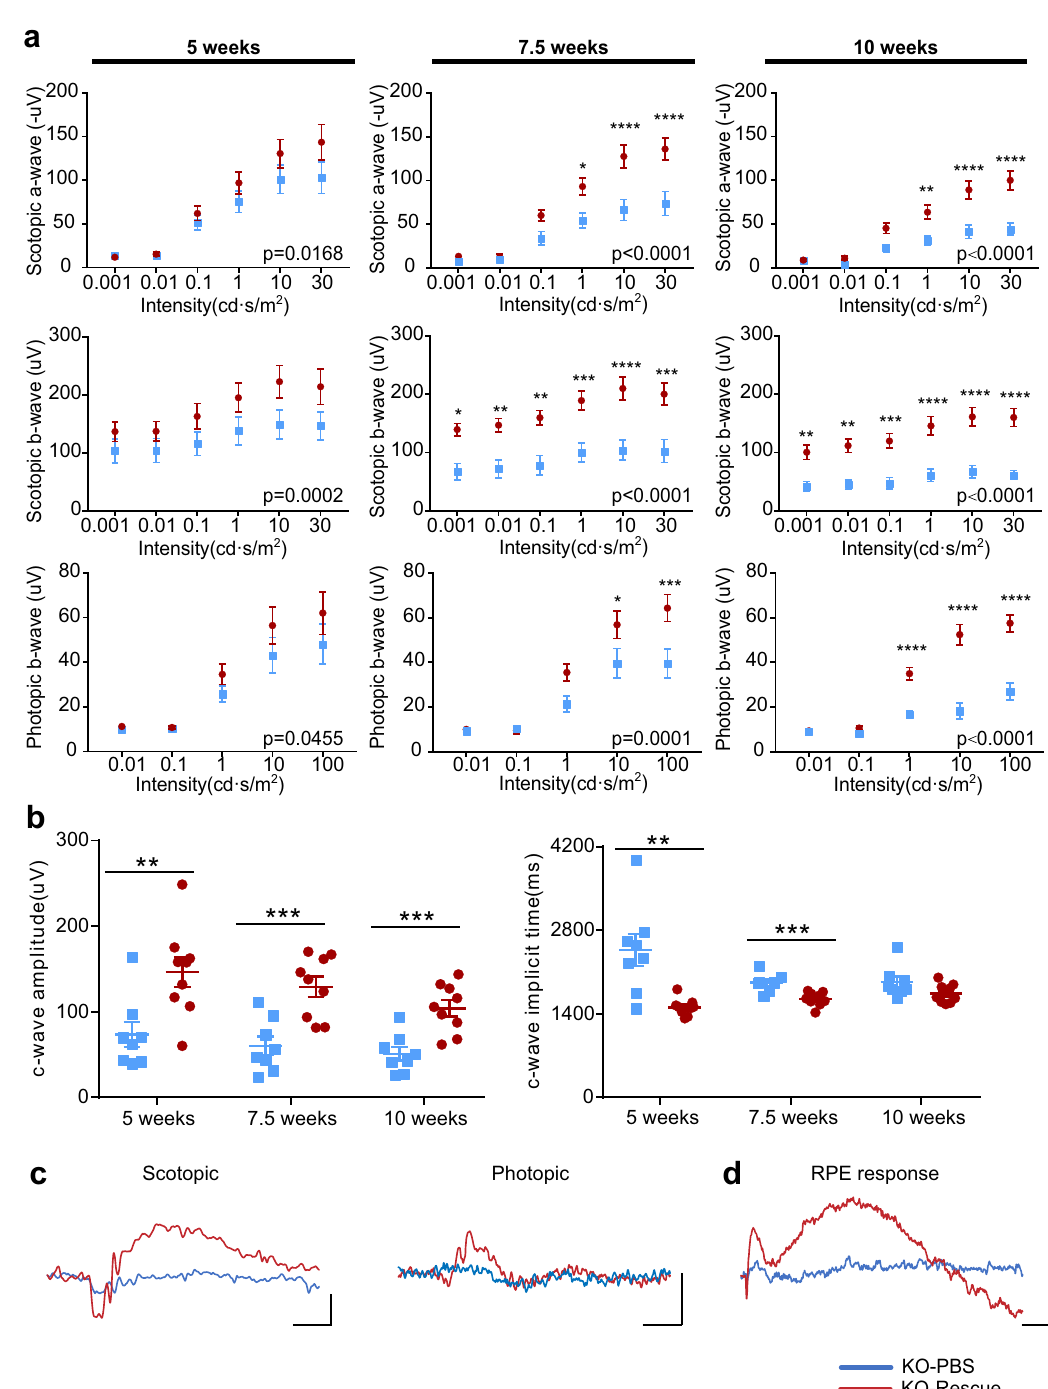
Fig. 8 | Gene augmentation preserves visual function of the Prpf31 KO retina. a Quanti fi cation of ERG scotopic and photopic a- and b-waves amplitudes ( n =8). b ERG recordings of dark-adapted c-waves ( n =8). c Representative scotopic (10cd·s/m 2 fl ash) and photopic (10cd·s/m 2 fl ash) ERG recordings 10 weeks (p.i.). Scale bar vertical, 50uV; Scale bar horizontal, 50ms. d Representative c-wave recordings 10 weeks (p.i.) Scale bar vertical, 50uV; Scale bar horizontal, 500ms. KO-PBS data points and traces are shown in blue; KO-Rescue is shown in red.